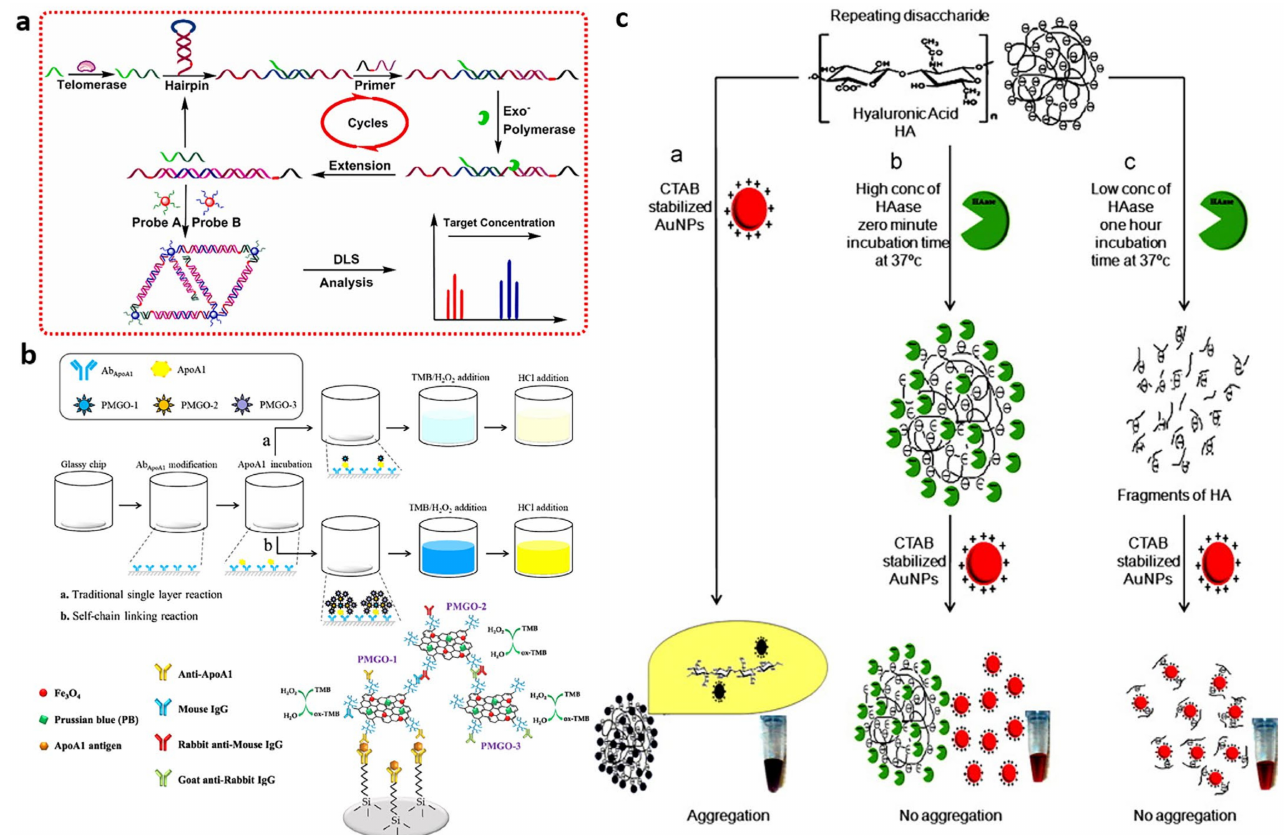
Figure 6. ( a ) Schematic of the telomerase detection strategy. (Reprinted with permission Ref. [58]. Copyright © 2019 Elsevier B.V.) ( b ) Schematic of the traditional signal ( up ) and self-chain linking reaction ( down ) for the ApoA1 detection. (Reprinted with permission Ref. [66]. Copyright © 2018 Elsevier B.V.) ( c ) The mechanism of cationic AuNP-based colorimetric assay for the direct detection of HAase activity. (Reprinted with permission Ref. [67]. Copyright © 2013 Elsevier